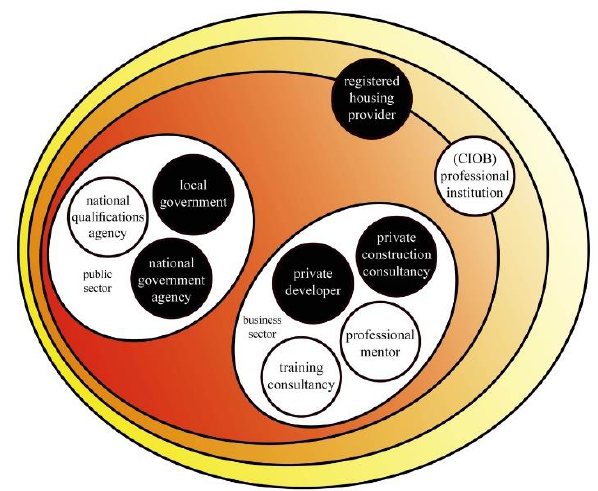
Figure 12. Mapping of Health, Safety, Welfare and the Environment Module for the CIOB Chartered Membership Programme.